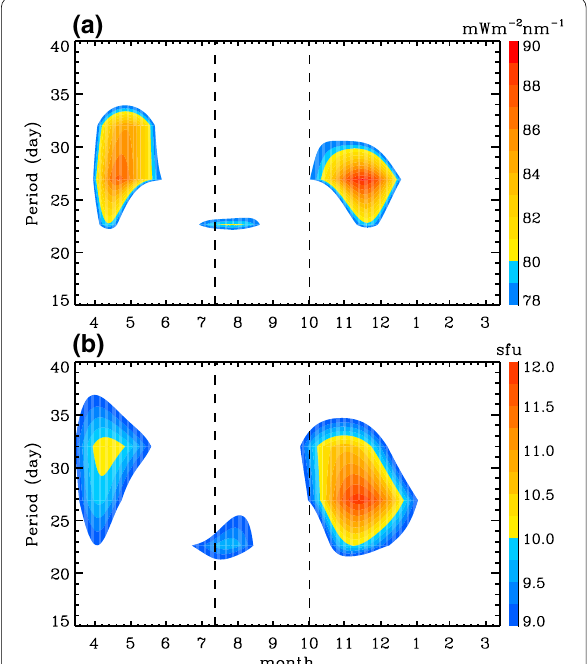
Fig. 12 Wavelet spectra of a Lyman-α flux and b F10.7 for 1 year from 13 April 2006 to 12 April 2007. The months are marked on the last day of each month. The two dashed vertical lines are marked on 12 August 2006 and 31 October 2006,